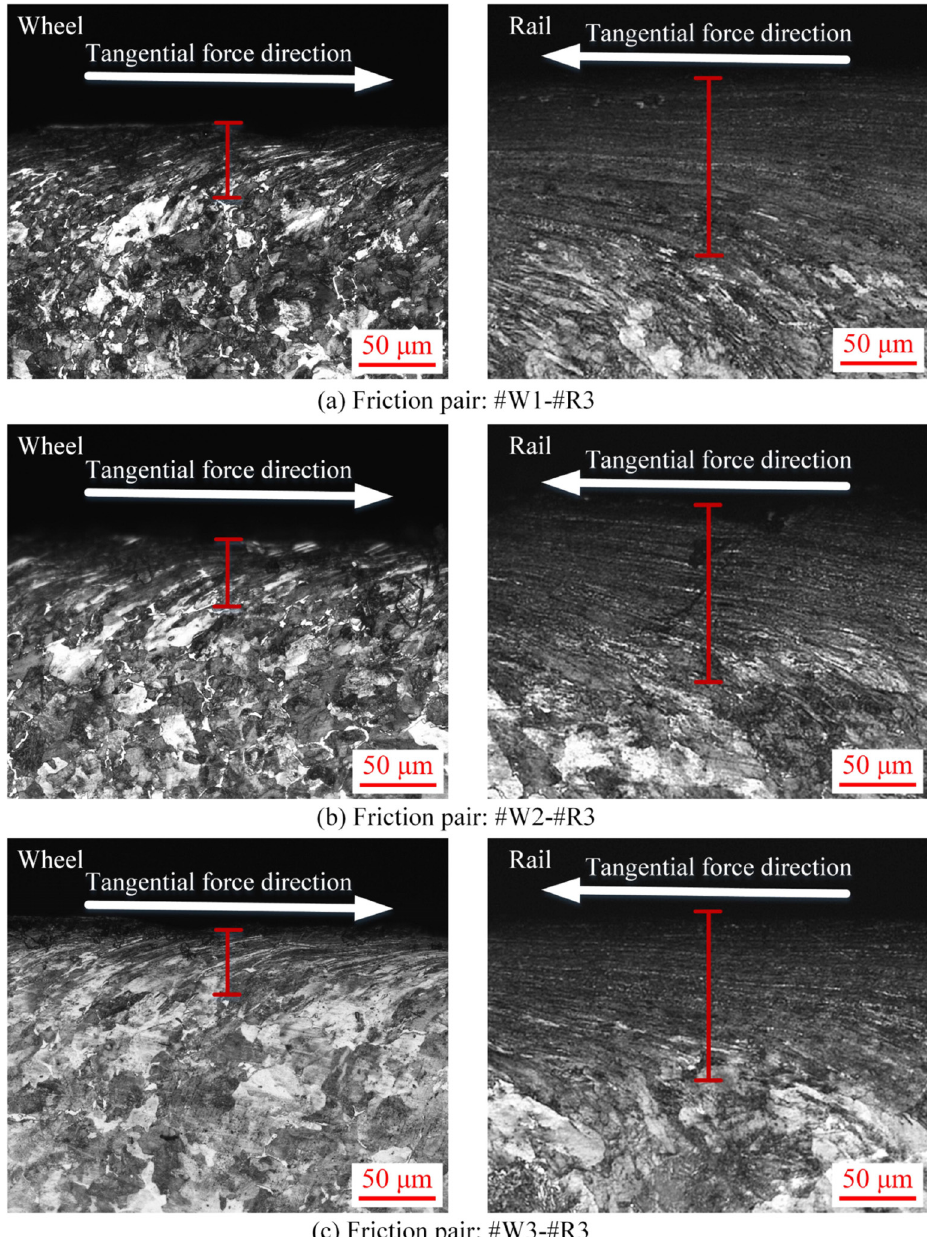
Figure 16. OM micrographs of subsurface plastic deformation of the wheel/rail discs under different friction pairs: ( a ) #W1-#R3; ( b ) #W2-#R3; ( c ) #W3-#R3.